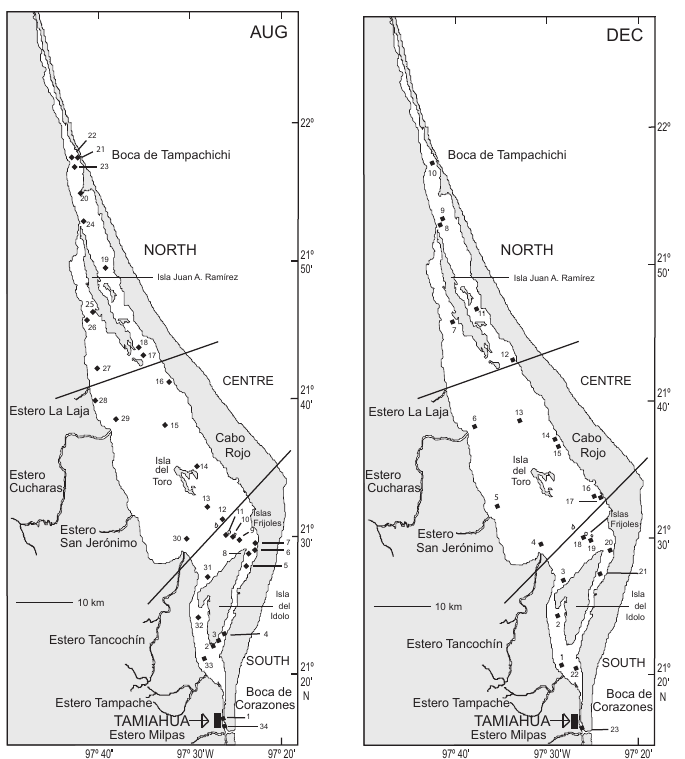
Fig. 1. Laguna de Tamiahua, Gulf of Mexico, Mexico—toponymy, regions, and the sampling stations where fish were collected in 1996; August = left : 2 = southern point of Isla del Idolo, 3 = southern point of Isla del Idolo, 5 = off Isla del Idolo, 6 = Nuestra Señora, 7 = Nuestra Señora, 9 = between Punta de Martínez and Islas Frijoles, 10 = Isla Frijoles Este, 13 = between Isla Pájaros and Isla del Toro, 16 = La Restinga, 17 = north of Isla Burros, 18 = south point of Isla Juan A. Ramírez, 19 = north of Isla Frontón, 20 = southeast of Las Chacas, 21 = Boca de Tampachichi, 22 = west of Boca de Tampachichi, 23 = Las Chacas, 24 = northern point of Isla Juan A. Ramírez, 27 = northeast of La Laja, 29 = off Estero Cucharas, 30 = off Estero Tancochín, 31 = Los Pipianes, 32 = Ensenada Grande, 33 = off Estero Tampache, 34 = Boca de Corazones; December = right : 1 = off Estero Tampache, 2 = Ensenada Grande, 5 = off Estero San Jerónimo, 6 = off Estero Cucharas, 8 = northern point of Isla Juan A. Ramírez, 9 = northern point of Isla Juan A. Ramírez, 10 = Boca de Tampachichi, 14 = north-east of Isla del Toro, 15 = north-east of Isla del Toro, 18 = Isla Frijoles Este, 20 = Nuestra Señora, 21 = off Isla del Idolo, 22 = La Lata, 23 = Boca de